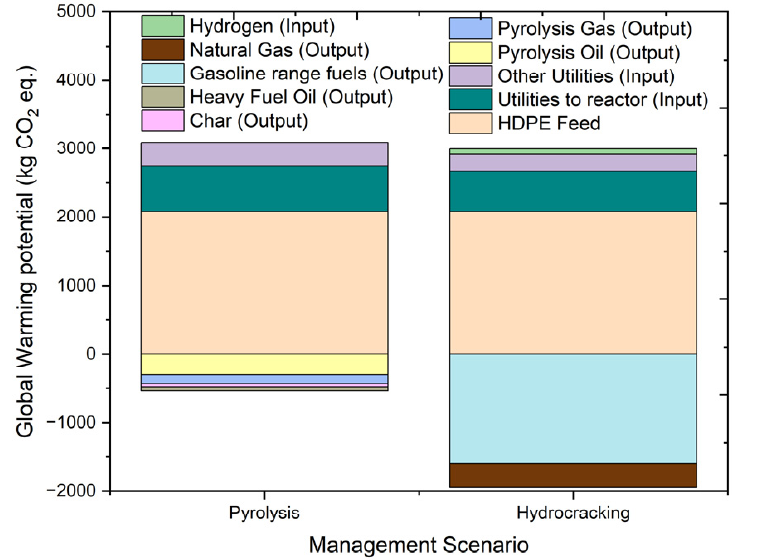
Figure 9. Impact assessment of pyrolysis and hydrocracking for the management of waste on global warming potential (kg CO 2